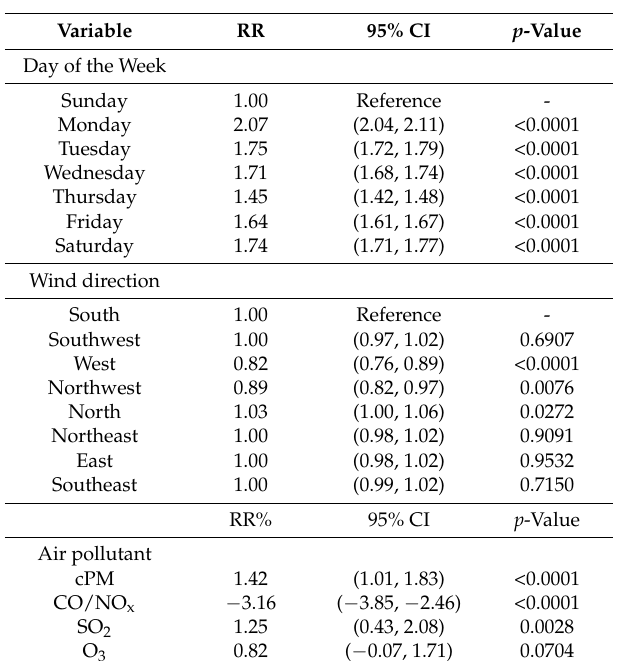
Table 2. Percentage change of relative risk (RR) in children’s clinic visits for asthma from 2005 to 2010.